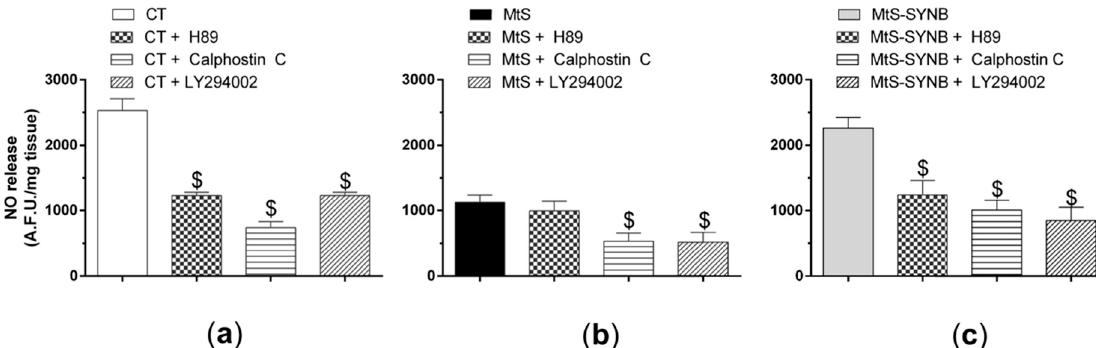
Figure 7. Mesenteric segments from CT ( a ), MtS ( b ) and MtS-SYNB ( c ) rats were preincubated with a protein kinase A –PKA- inhibitor H89 (1 μ mol/L), a protein kinase C –PKC- inhibitor Calfostin C (0.1 μ mol/L) or a phosphatidylinositol 3-kinase -PI3K- inhibitor LY294002 (10 μ mol/L). NO release was induced by EFS. Data are expressed as arbitrary fluorescence units (A.F.U.)/mg tissue. Statistical analysis: One-way ANOVA followed by a Newman–Keuls post-hoc test. $ p < 0.05 conditions without inhibitor vs. conditions with respective inhibitor.